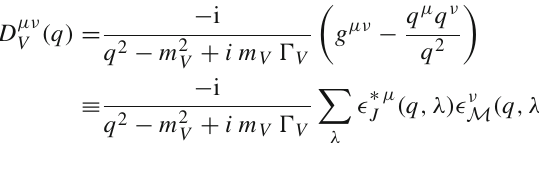
μ . These represent the p → jV